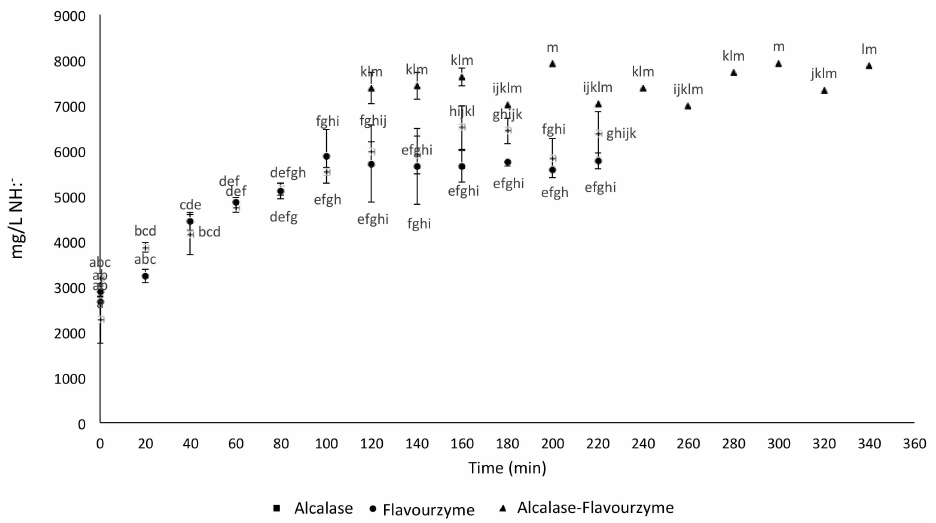
Figure 1. Free amine groups concentration during amaranth protein hydrolysis. * Di ff erent letters indicate statistically significant di ff erences between